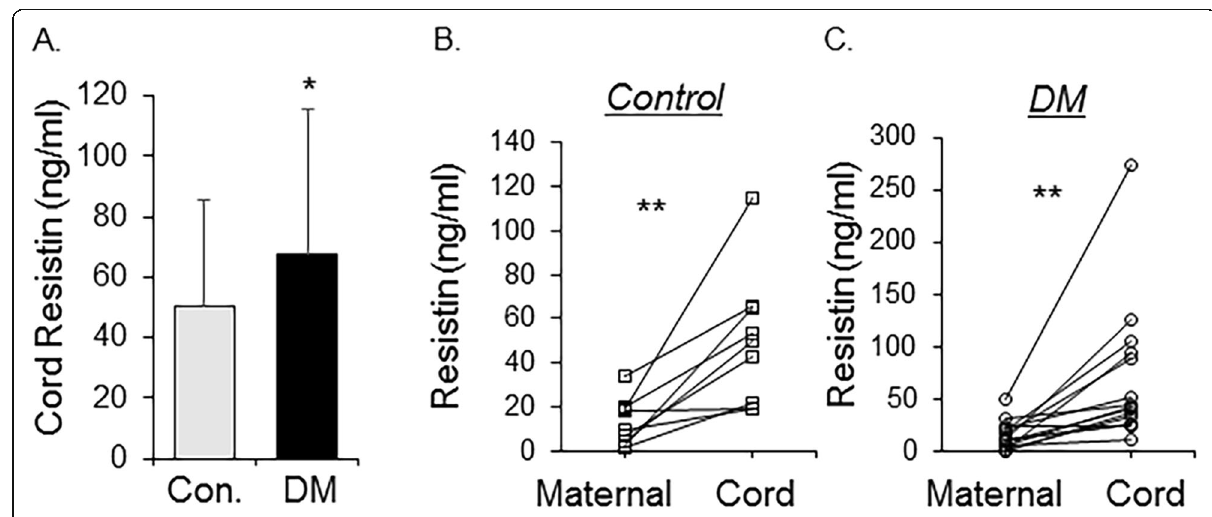
Fig. 1 Serum resistin levels in cord and maternal blood. a Resistin concentrations were higher in the cord blood of diabetic women (DM) compared to healthy controls (Mean ± SD, * P < 0.05, N = 81 in control, N = 42 in DM); b and c Pairwise comparison of resistin levels in maternal and cord blood. N = 9 pairs of control ( b ) and N = 15 pairs of Diabetes ( c ), ** P < 0.01 between maternal and cord